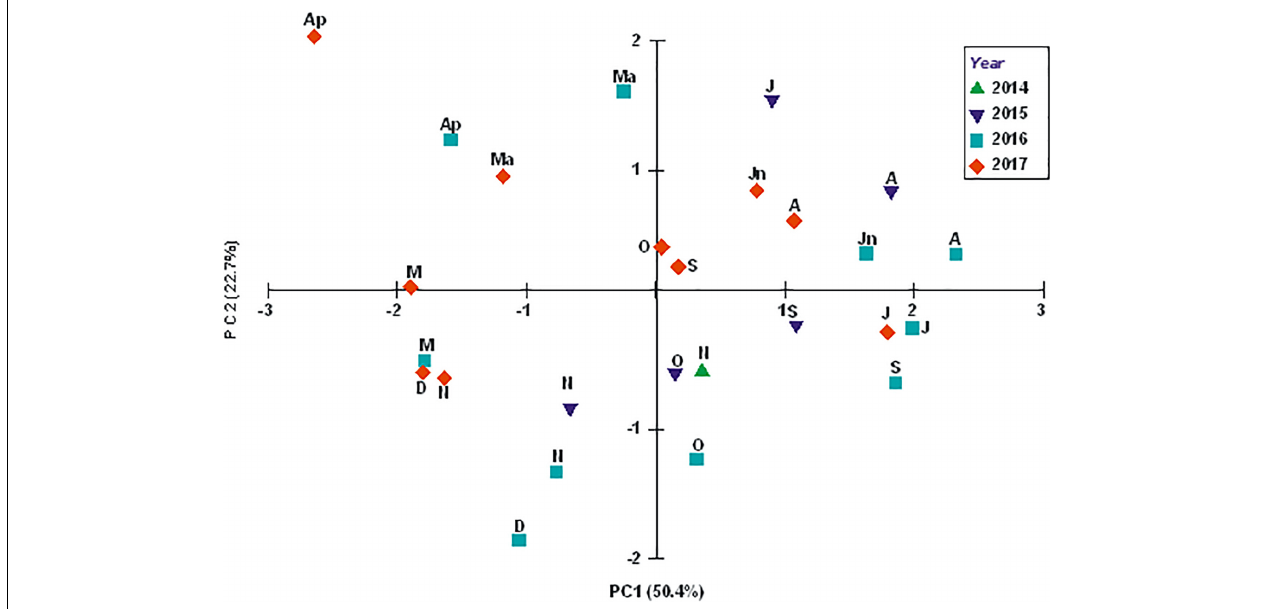
FIGURE 2 | Environmental variables-based PCA plot for sampling events (months of 2014, 2015, 2016, and 2017) at station ZS6. Letters next to symbols denote months (M, March; Ap, April; Ma, May; Jn, June; J, July; A, August; S, September; O, October; N, November; and D, December).